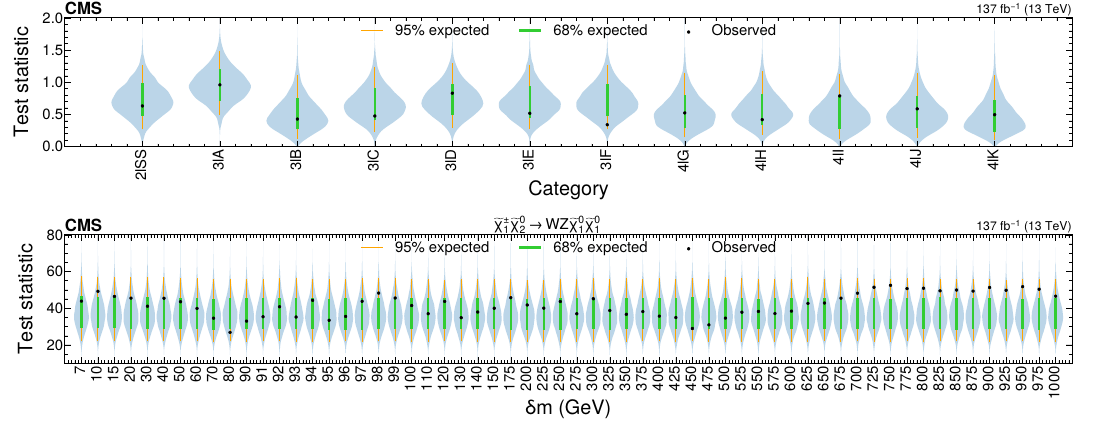
Figure 15 . Expected test statistic distribution for a background-only fit compared to the observed test statistic value, drawn as black dots, for the search regions in each event category (upper plot) and the neural network targeting WZ -mediated superpartner decays for each δm evaluation (lower plot). The gray shaded area represents the (symmetrized) probability density of the expected test statistic distribution, with 68 and 95% expected ranges respectively drawn in green and orange.